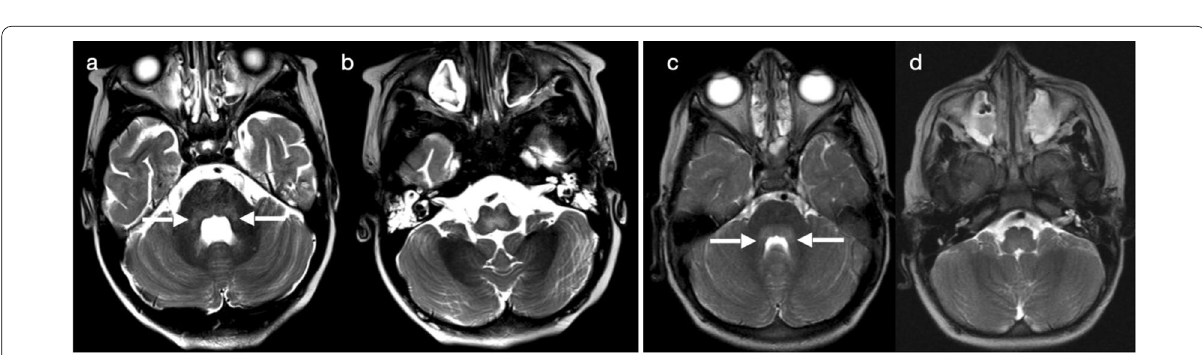
Fig. 16 T2 hyperintensity in posterior fossa—dorsal pons (Pattern 6A). Case 1: 4‑year‑old child with fluctuating GCS. Stool was positive for enterovirus (serotype E‑71). T2‑weighted imaging ( a , b ) demonstrated hyperintensity of the dorsal pons and medulla, with extension of signal abnormality into the middle cerebellar peduncles bilaterally (arrows). Case 2: 3‑year‑old child with lethargy, vomiting and fever, as well as right facial nerve palsy and unsteadiness on feet. Stool was positive for enterovirus (serotype not known). T2‑weighted imaging ( c , d ) demonstrated hyperintensity of the dorsal pons and medulla, with extension of signal abnormality into the middle cerebellar peduncles bilaterally (arrows)